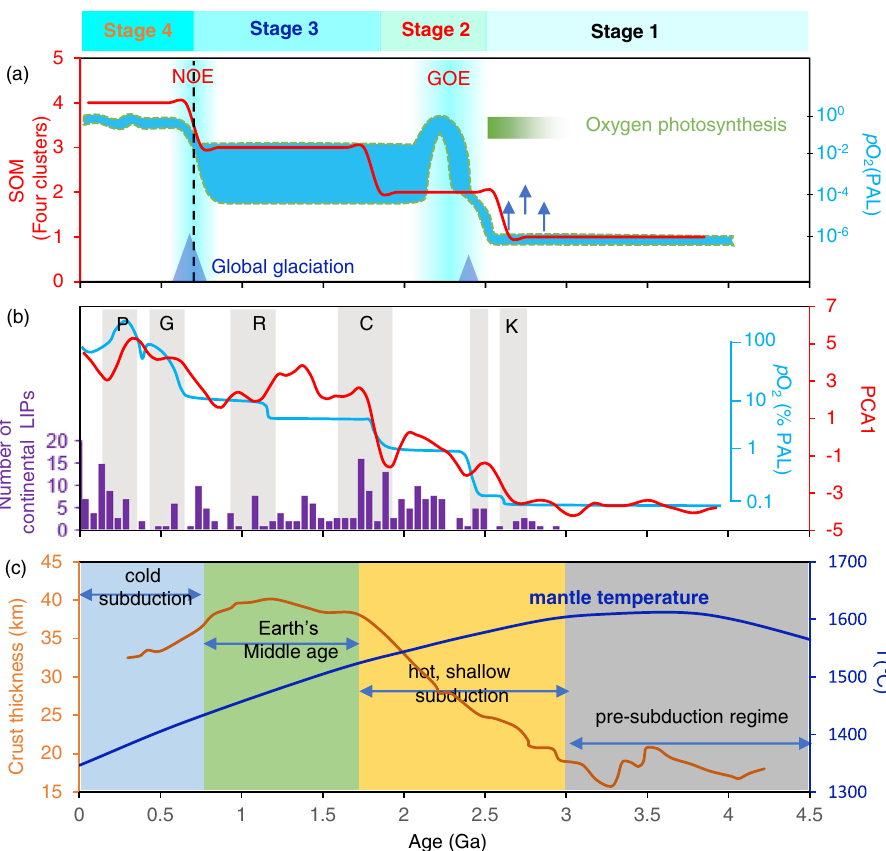
Fig. 4 | Coupling of ma fi c igneous geochemical evolution and atmospheric igneous compositional evolution through time (red line), gradual step increases in oxygenation. a Self-organizing map (SOM) classi fi cation of ma fi c igneous compo- atmosphericO 2 suggested by Campbelland Allen 46 (blue solid line),and numbersof continental large igneous provinces (LIPs) 78 . c Four stages of plate tectonics sitional evolution through time using four clusters (red line). The blue box shows a “ classicaltwo-step ” view of atmospheric oxygen evolution 10 . Arrows denote possible evolution 43 ; orange curve represents variation in the thickness of new continental “ whiffs ” of O fi rst principal component (PCA1) of ma fi c crust through time, and blue line is for secular cooling of mantle 2 in the Late Archaean. b The